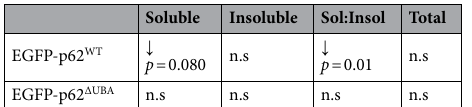
Table 1. Expression of EGFP-p62 reduces TDP-43 solubility in a UBA-dependent manner.